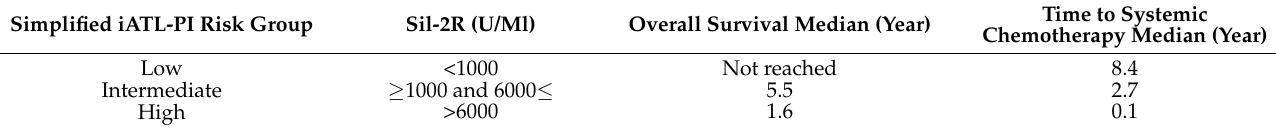
Table 3. Indolent ATL-PI